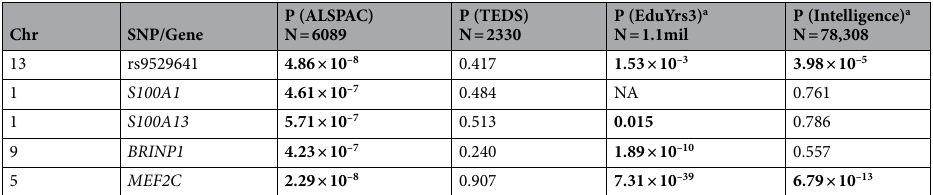
Table 2. Table of SNP and gene-level replication in TEDS, EduYrs3 and Intelligence GWAS. a Results were extracted from the Supplementary Tables provided in the papers and included all participants. Bolded figures show significant associations (p < 0.05).